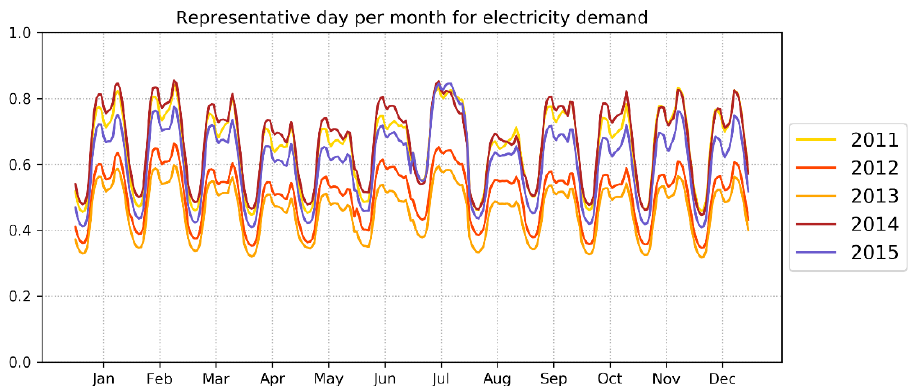
Figure 2. Representative day per month for electricity demand from 2011 to 2015.